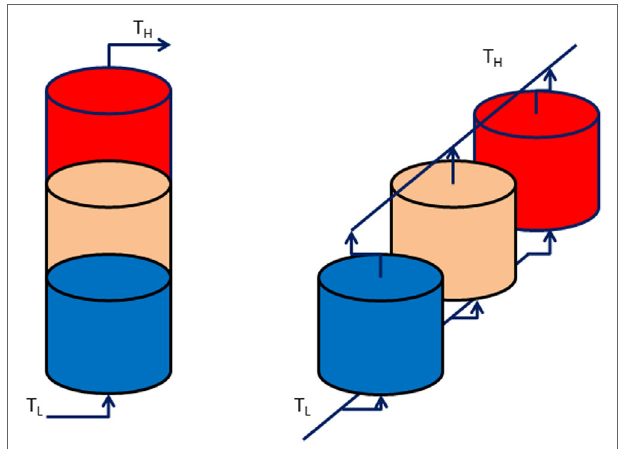
FigURe 5 | Thermal stratification could be enhanced by using multi-segment tanks (left) or multiple modular tanks in series or in parallel